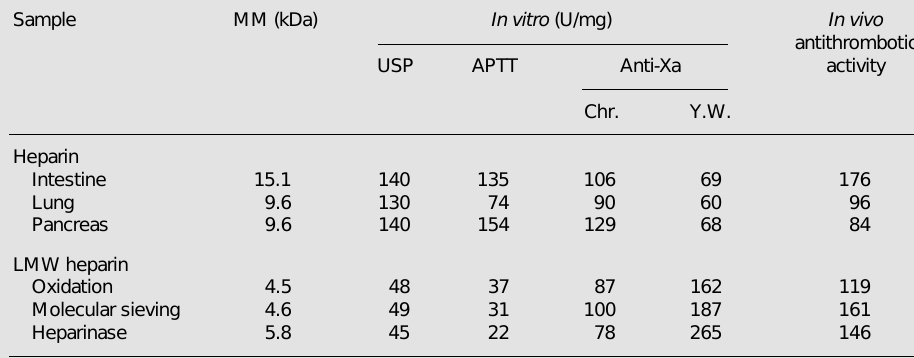
Table 1. In vitro anticoagulant activities and in vivo antithrombotic activities of heparins and low molecular weight (LMW)